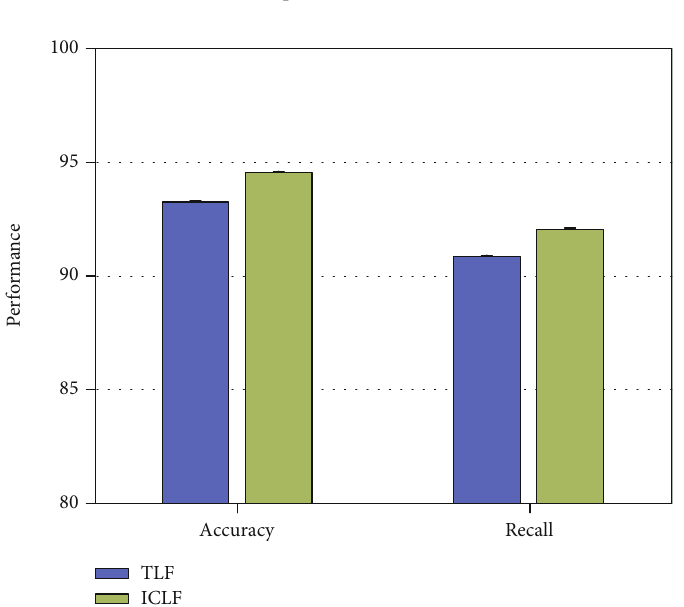
Figure 5: Comparison of FIW and LDIW.